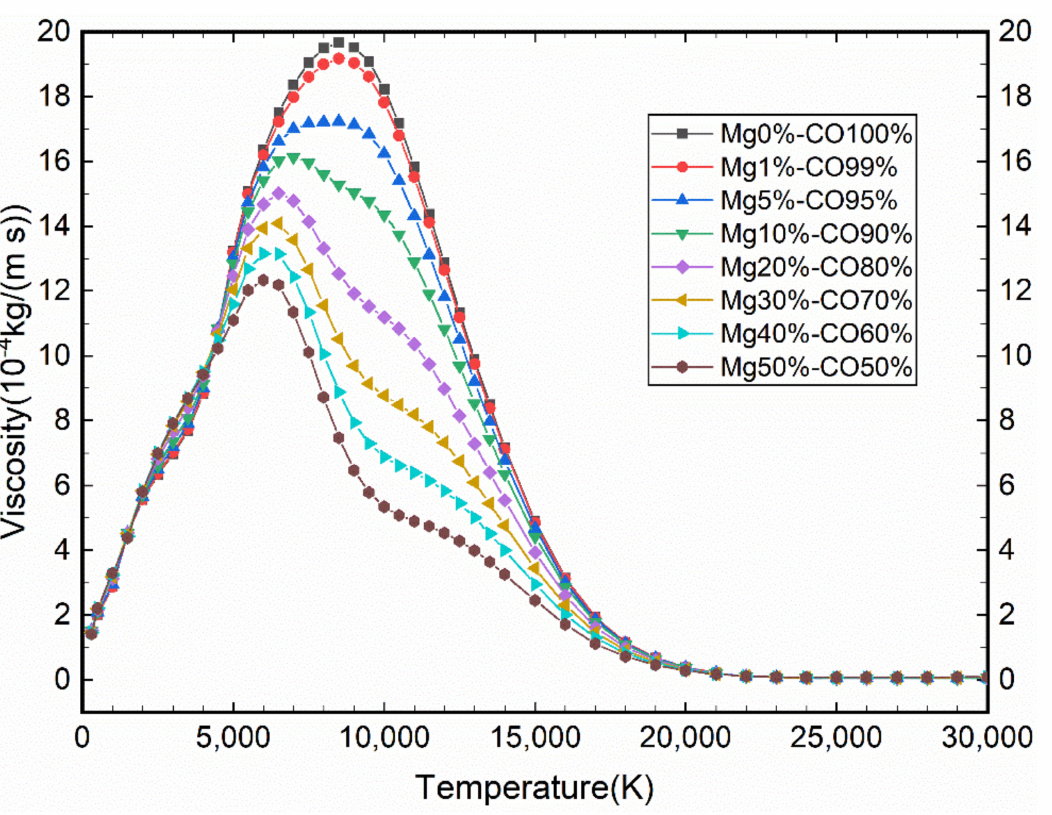
Figure 15. The curves of viscosity for different proportion Mg-CO mixtures plasma at a temperature of 300–30,000 K and 0.1